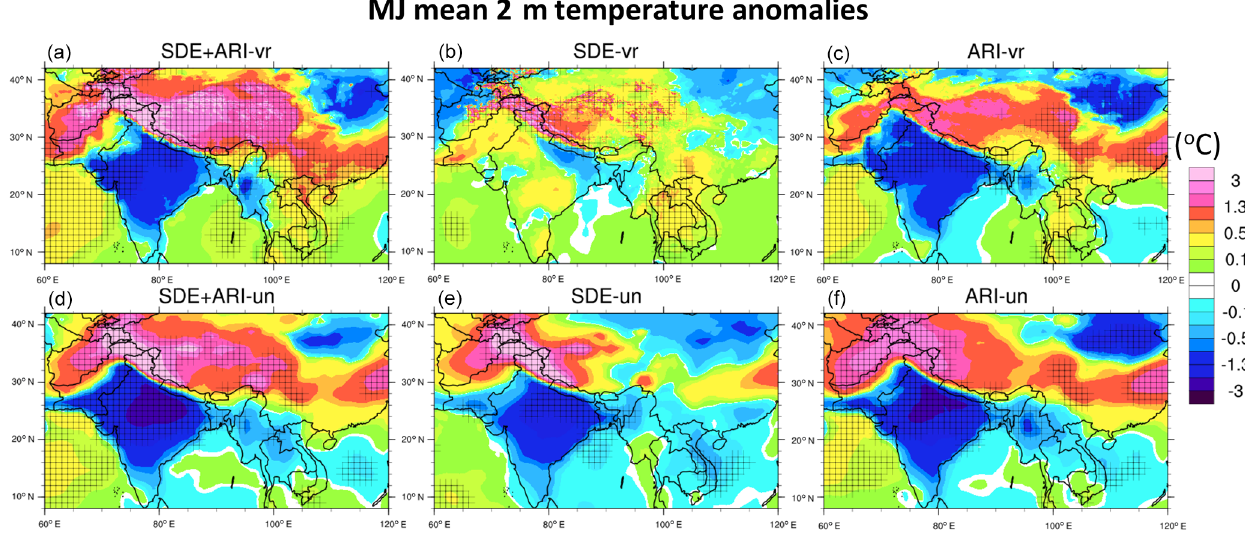
Figure 15. Anomalous 2m temperatures during May–June due to BCD (a) SDE + ARI, (b) SDE, and (c) ARI in the VR experiment. Panels (d–f) are the same as in (a) – (c) but are for the UN